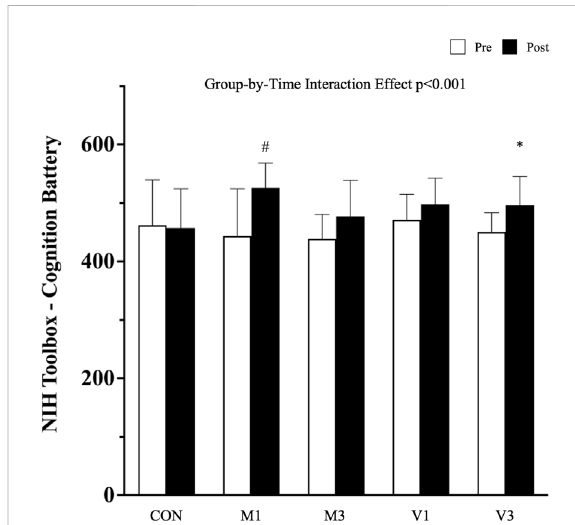
FIGURE 3 Cognitive performance measured by NIH toolbox-cognition battery. Data are expressed as mean (standard deviation). CON: stretching exercise control group, M1: moderate-intensity once- a-week walking group, M3: moderate-intensity thrice-a- week walking group, V1: vigorous-intensity once-a-week walking group,andV3:vigorous-intensitythrice-a-weekwalkinggroup.#: p < 0.001 compared with CON at the post-intervention measurement; *: p < 0.05 compared with CON at the post- intervention